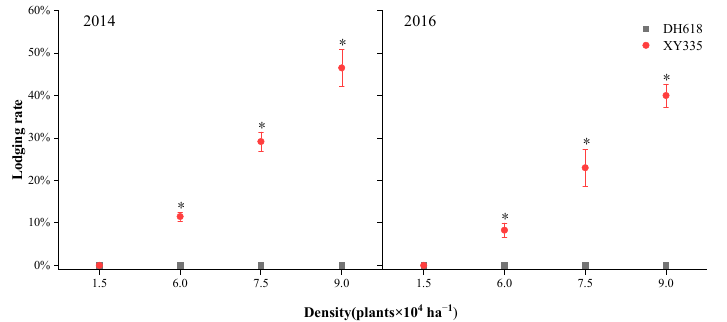
Figure 1. Field lodging rate of DH618 and XY335 under different planting densities in 2014 and 2016. * Significant difference at p < 0.05.